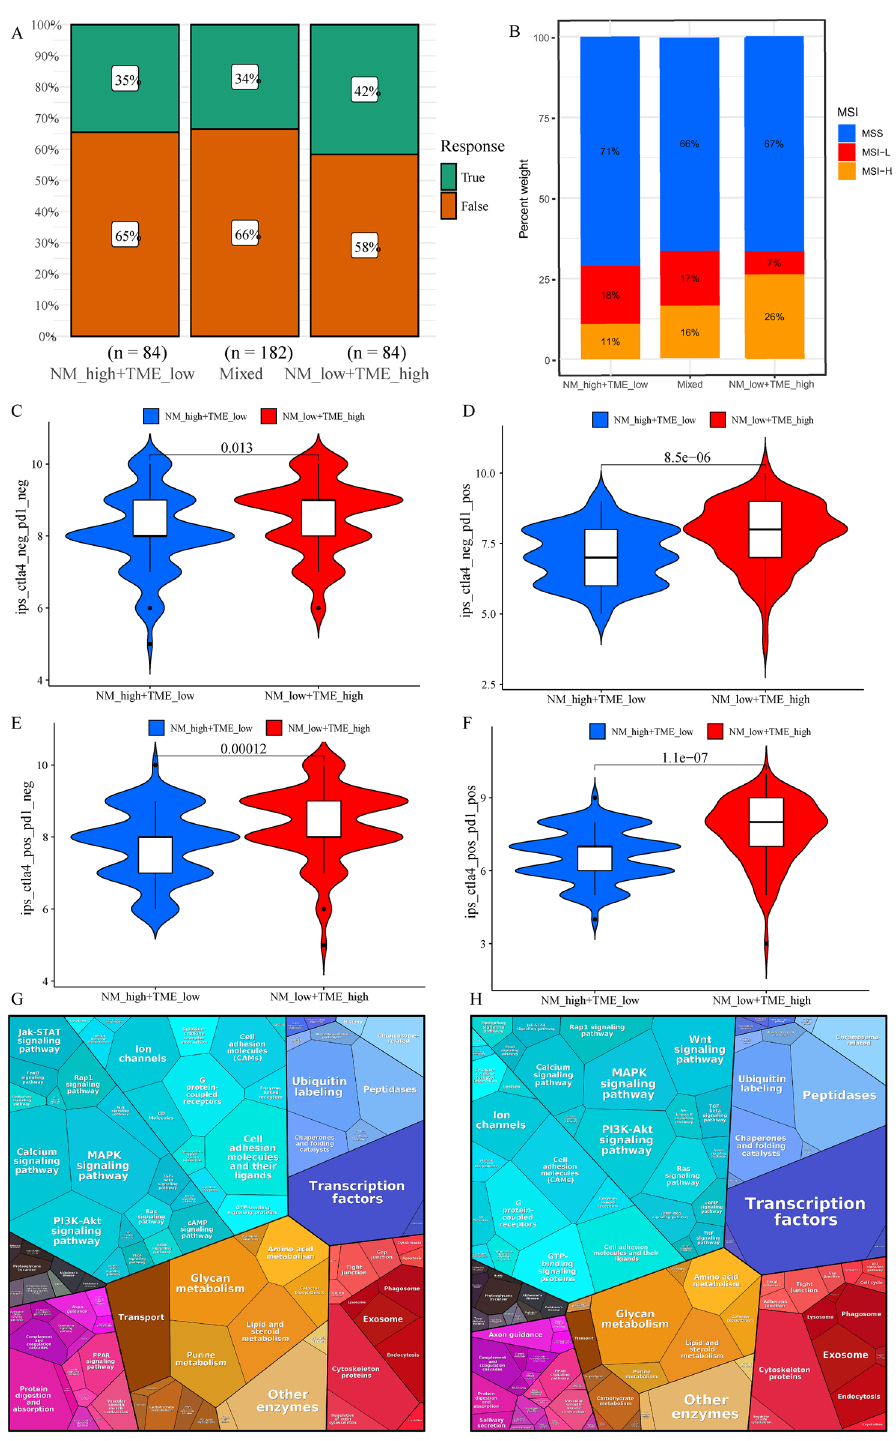
Figure 8. The role of NM-TME classifier in immunotherapy. ( A ) Proportion of response to immunotherapy in different groups. ( B ) Proportion of MSI in different groups. ( C – F ) Comparison of the relative distribution of IPS across groups with high NM/low TME and low NM/high TME. Functional analysis in the NMlow/ TMEhigh group ( G ) and responder of patients under immunotherapy ( H ) illustrated using Proteomaps. A little polygon represents a unique KEGG pathway. NM nucleotide metabolism, TME tumour microenvironment, MSI microsatellite instability, IPS